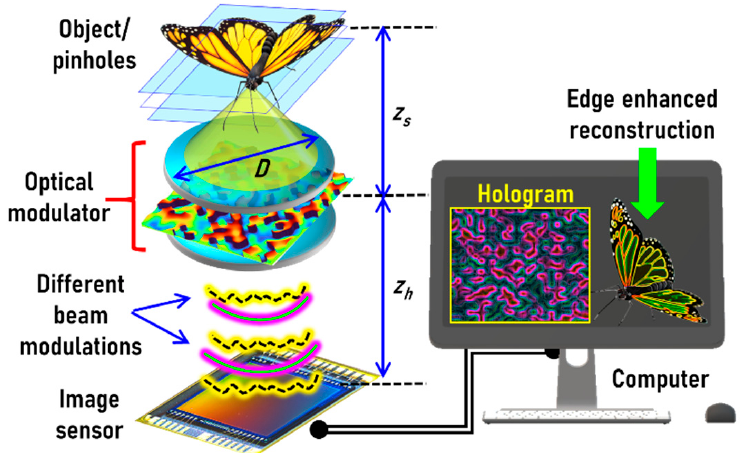
Figure 1. Optical configuration of spatially incoherent imager with coherent interference between two differently modulated object beams. two differently modulated object